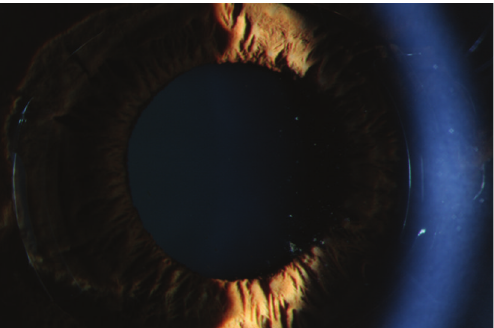
Figure 2: Cell deposits on the posterior surface of a foldable Artiflex phakic pIOL in the right eye, two months after surgery. The TASS has subsides.